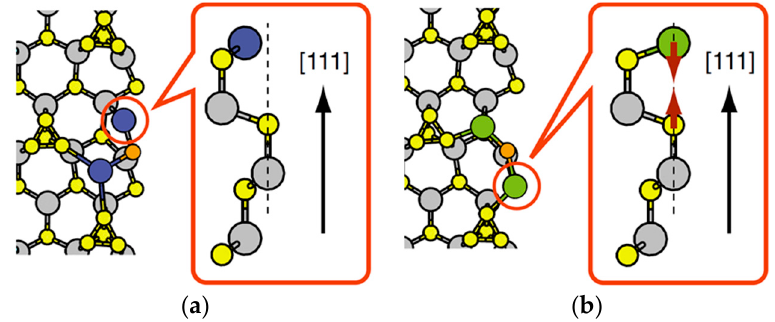
Figure 20. Top views of ( a ) 4In-ZB-2P and ( b ) 4In-WZ-2P adsorbed surfaces in the side area. There is a two-coordinated In adatom indicated by the red circle in 4In-ZB-2P, whereas all the In adatoms in 4In-WZ-2P are three-coordinated. The three-coordinated In adatom at the side facet in 4In-WZ-2P is due to the formation of In-P bonds with the P atom in the second layer. Reprinted with permission from [96]. Copyright (2011) by the Japan Society of Applied Physics.